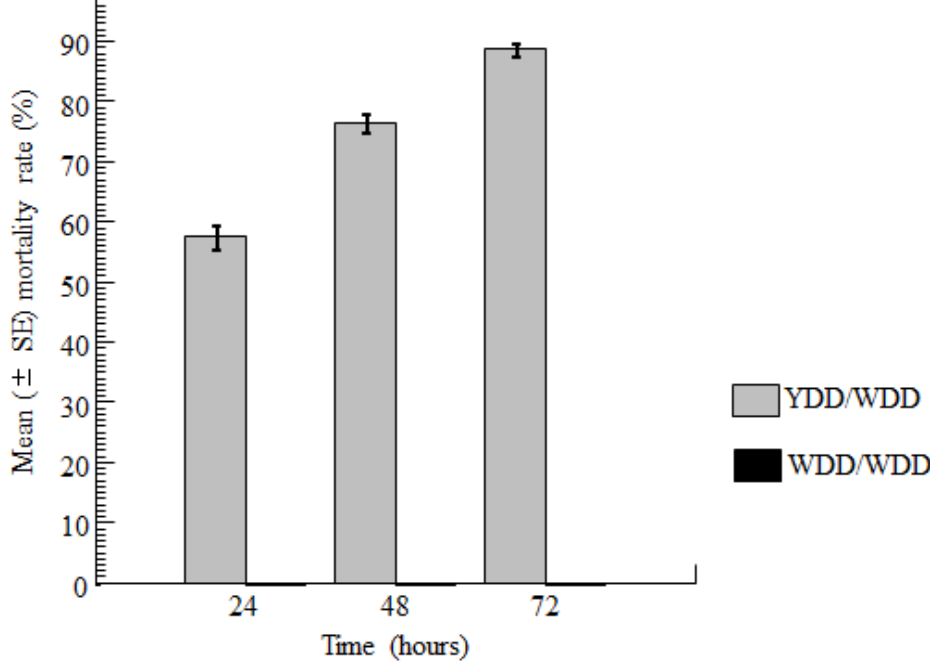
Figure 4. Mortality rates of the house flies when provided feeding opportunities in an enclosure with an assorted pair of floral arrangements (one YDD bearing toxic sugar and one WDD with non- toxic sugar) and another enclosure with paired